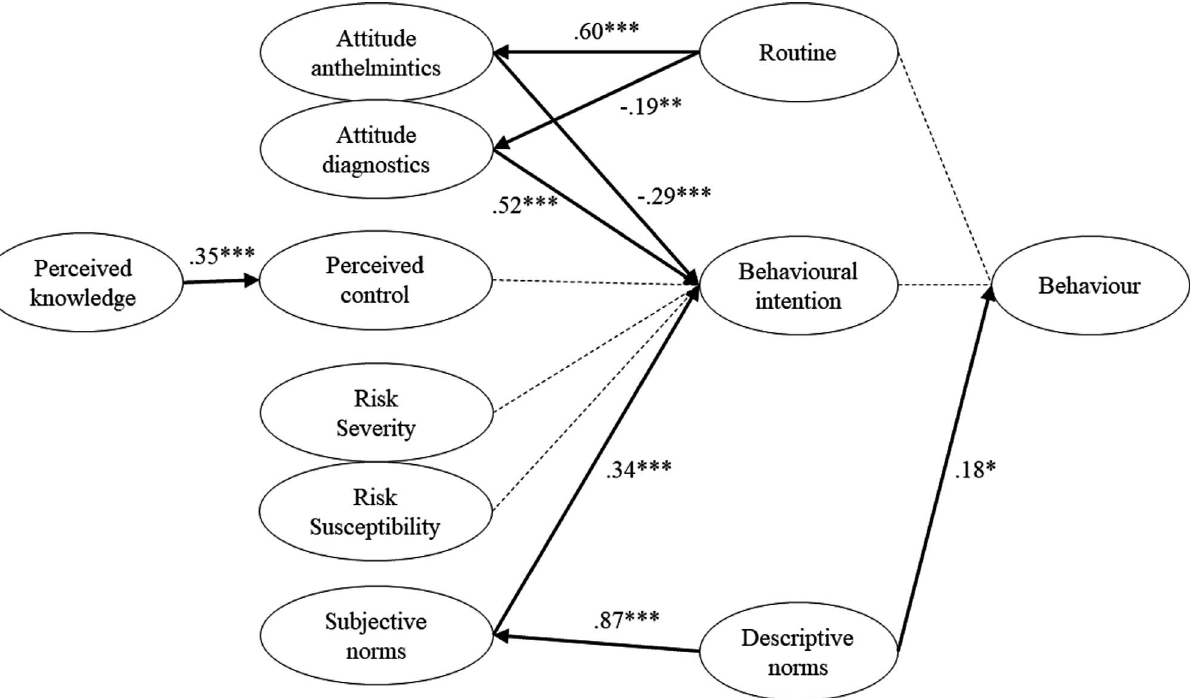
Figure 3. Structural equation model predicting dairy farmers ’ adoption of diagnostic methods for control of gastrointestinal nematode infections in Norway (N = 507). Notes. Full lines represent the signi fi cant equations with the numbers representing standardized regression coef fi cients; dotted lines represent insigni fi cant equations. *** p < 0.001, ** p < 0.01, * p <